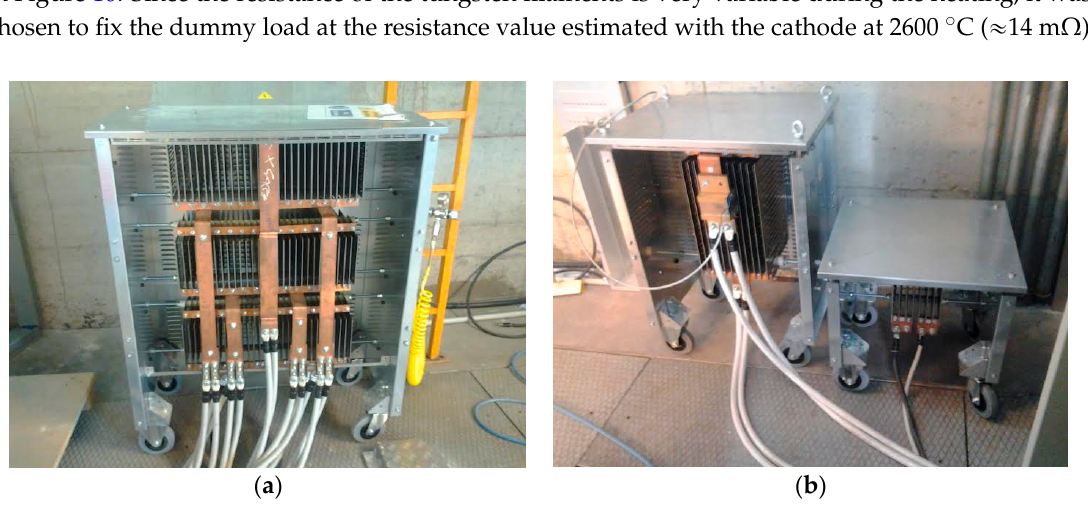
Figure 10. ( a ) Dummy load for the cathode power supply (6 star-connected resistors); ( b ) Dummy loads for the pinch (on the left) and PFC power supplies with their measurement shunts.